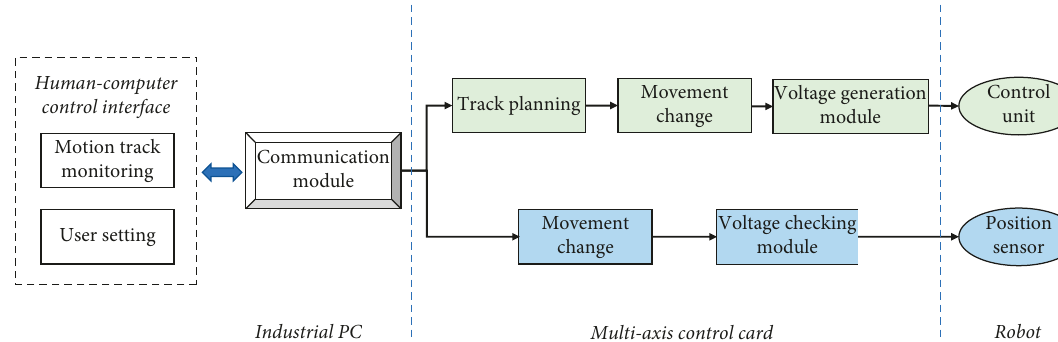
Figure 2: Robot automation control solution.